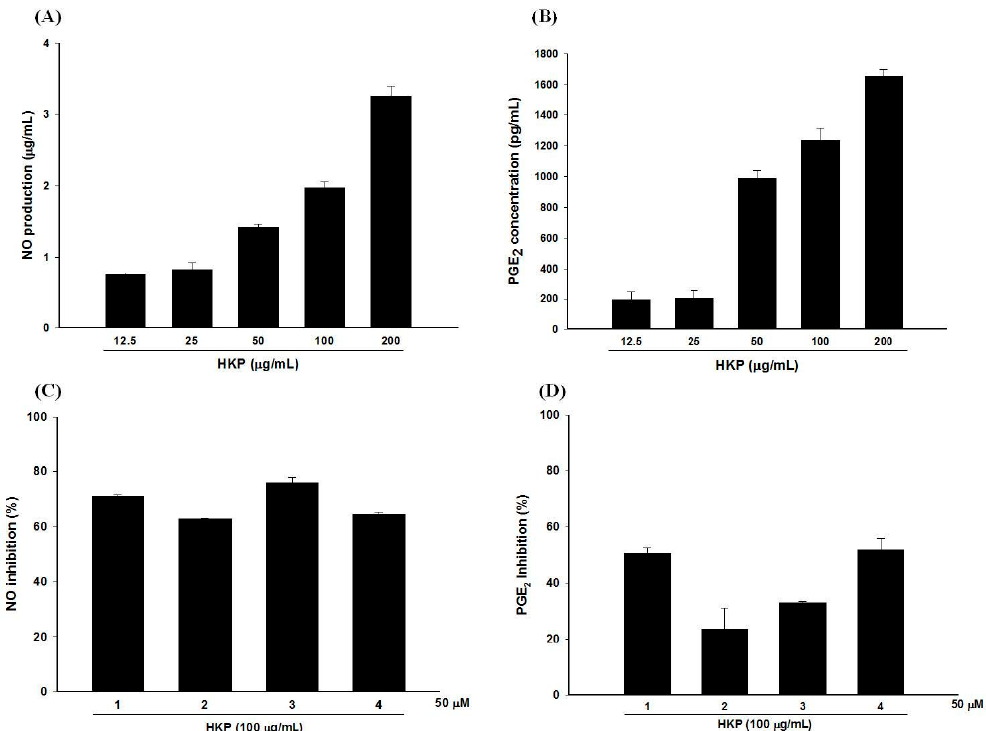
Figure 6. Heat-killed P . acnes (HKP) dose-dependently increased nitric oxide (NO) ( A ) and prostaglandin E 2 (PGE 2 ) ( B ) production by RAW 264.7 cells; Anti-inflammatory effects of hydrolysable tannins against HKP-induced NO ( C ) and PGE 2 ( D ) production by RAW 264.7 cells; Data are from three repeats.